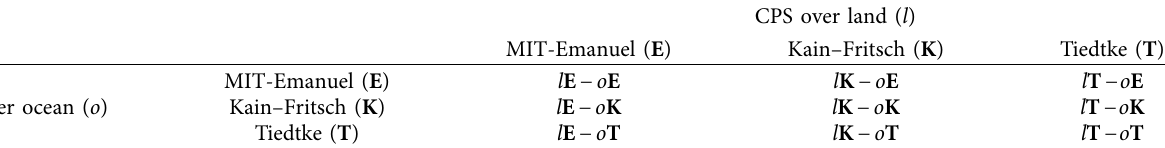
Table 1: Experimental design.